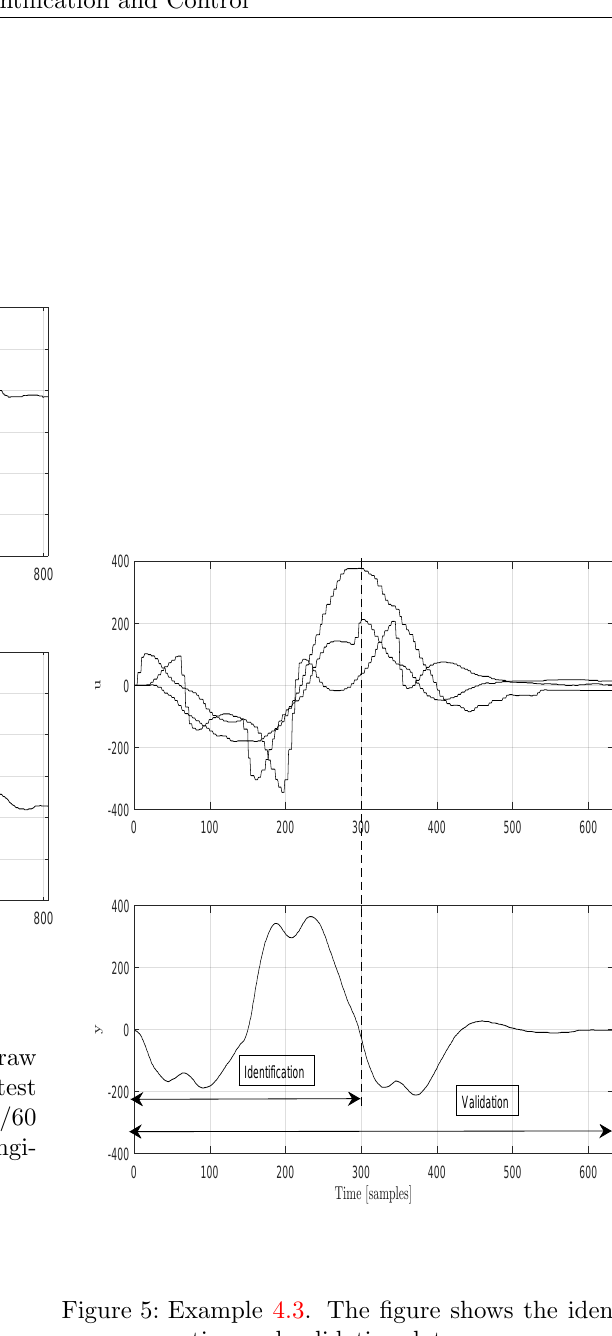
Figure 5: Example 4.3. The figure shows the identifi- cation and validation